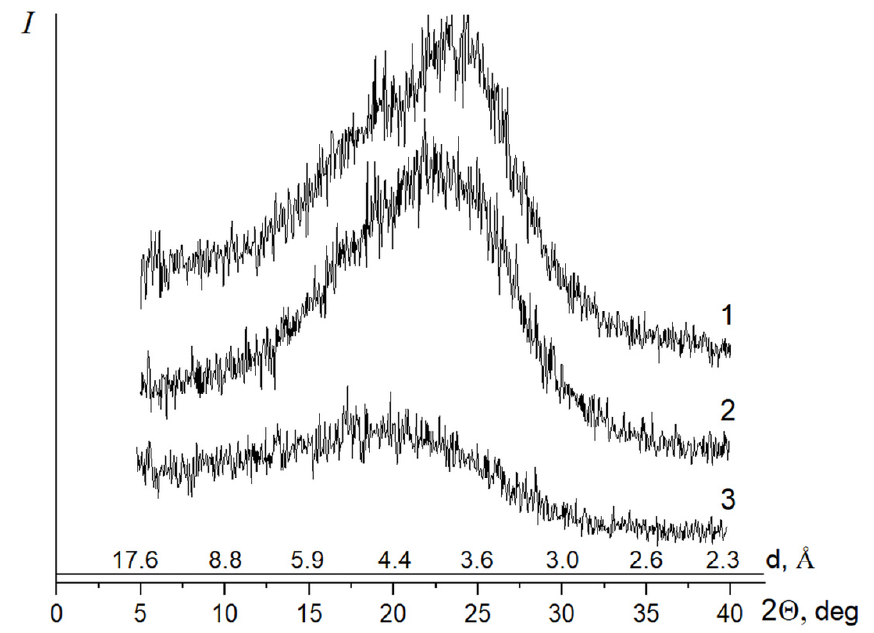
Figure 4. Diffraction patterns of coPAI-3 (curve 1), coPAI-2 (curve 2), and coPAI-1 (curve 3) with different ratios of PAI-1 and PAI-2 components.